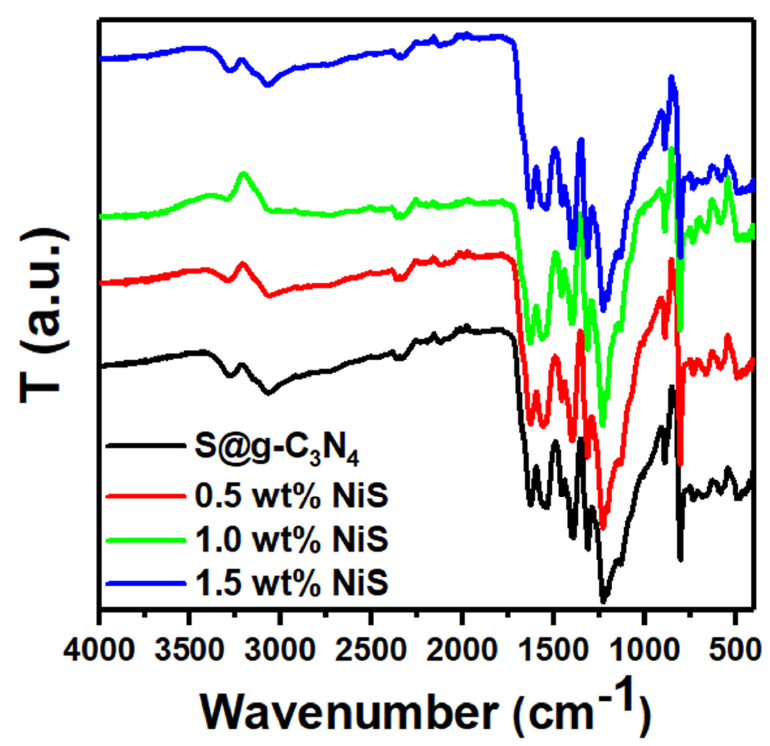
Figure 2. FTIR data of S@g-C 3 N 4 and NiS-g-C 3 N 4 nanocomposites.